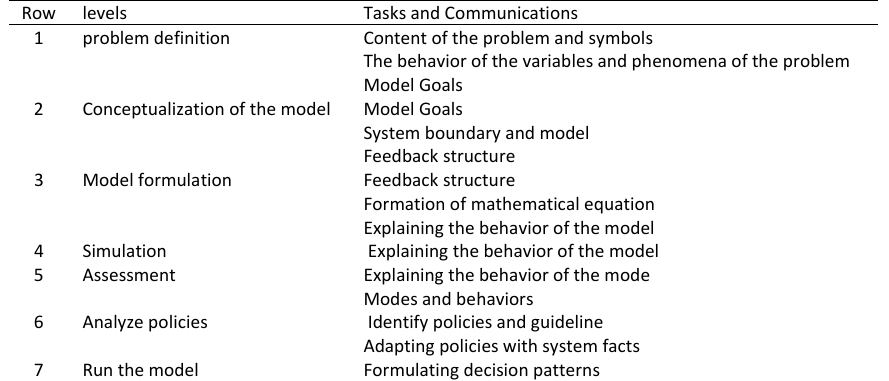
Fig. 6. The Impact of Improving Financial Services on SD Variables Fig. 6: The Impact of Improving Financial Services on SD Variables Table 1: Theoretical stages of modeling Table 3. Summary of Developed Scenarios and Identification of the Best